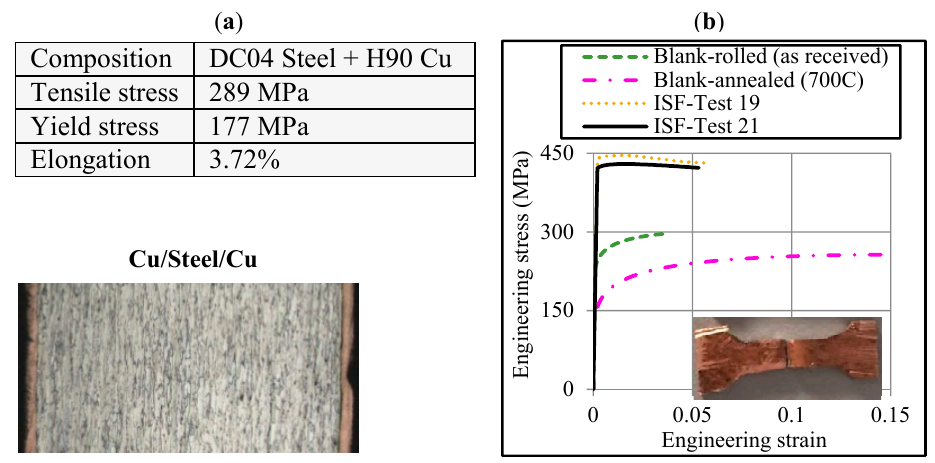
Figure 1. Test material: ( a ) Composition and structure and ( b ) stress-strain curves.